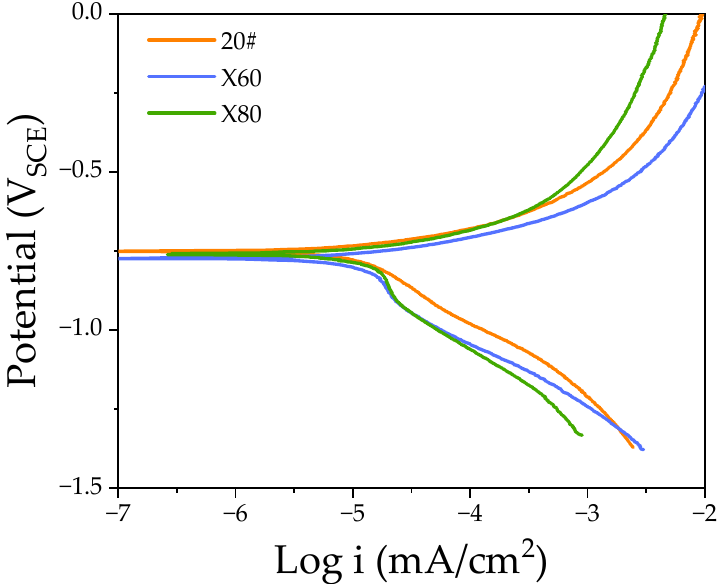
Figure 3. Open-circuit potential and test duration of 20#, X60, and X80 steels in NS4 solution. The polarization curve of 20#, X60, and X80 steels in NS4 solution, as shown in Figure 4, is analyzed employing iterative curve-fitting, and the analysis results are shown in Ta- ble 2. E corr is the corrosion potential of corrosion systems (mV SCE ), i corr is the corrosion cur- rent density ( μ A/cm 2 ), and Beta A and Beta C are the anodic and cathodic Tafel slopes, respectively. C r is the corrosion rate of the sample. i corr of the three steels is 6.48 μ A/cm 2 , 13.47 μ A/cm 2 , and 14.67 μ A/cm 2 , respectively, and the corresponding corrosion rates C r of the three samples are 3.01 mpy, 6.25 mpy, and 6.80 mpy, respectively. Figure 5 is the SEM